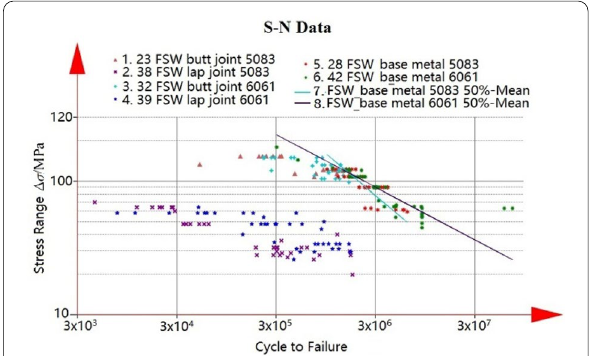
Figure 17 Fatigue life comparison between FSW and normal welding using nominal stress